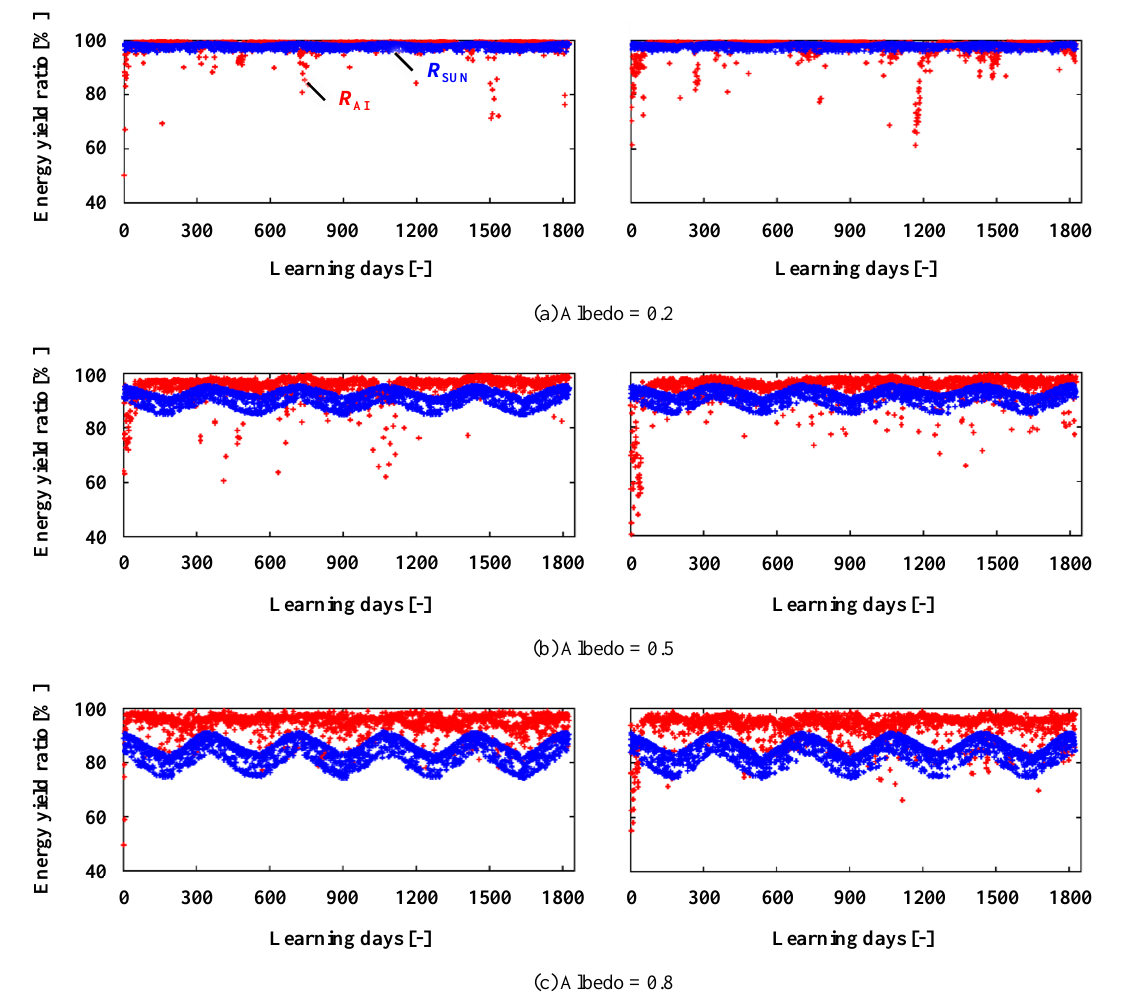
Figure 5. Variation of daily energy-yield ratio ( R ) in 5-year simulation ( left : RUN 1, right : RUN 2). R AI and R SUN depict the result by AI and sun-tracking controls, respectively.